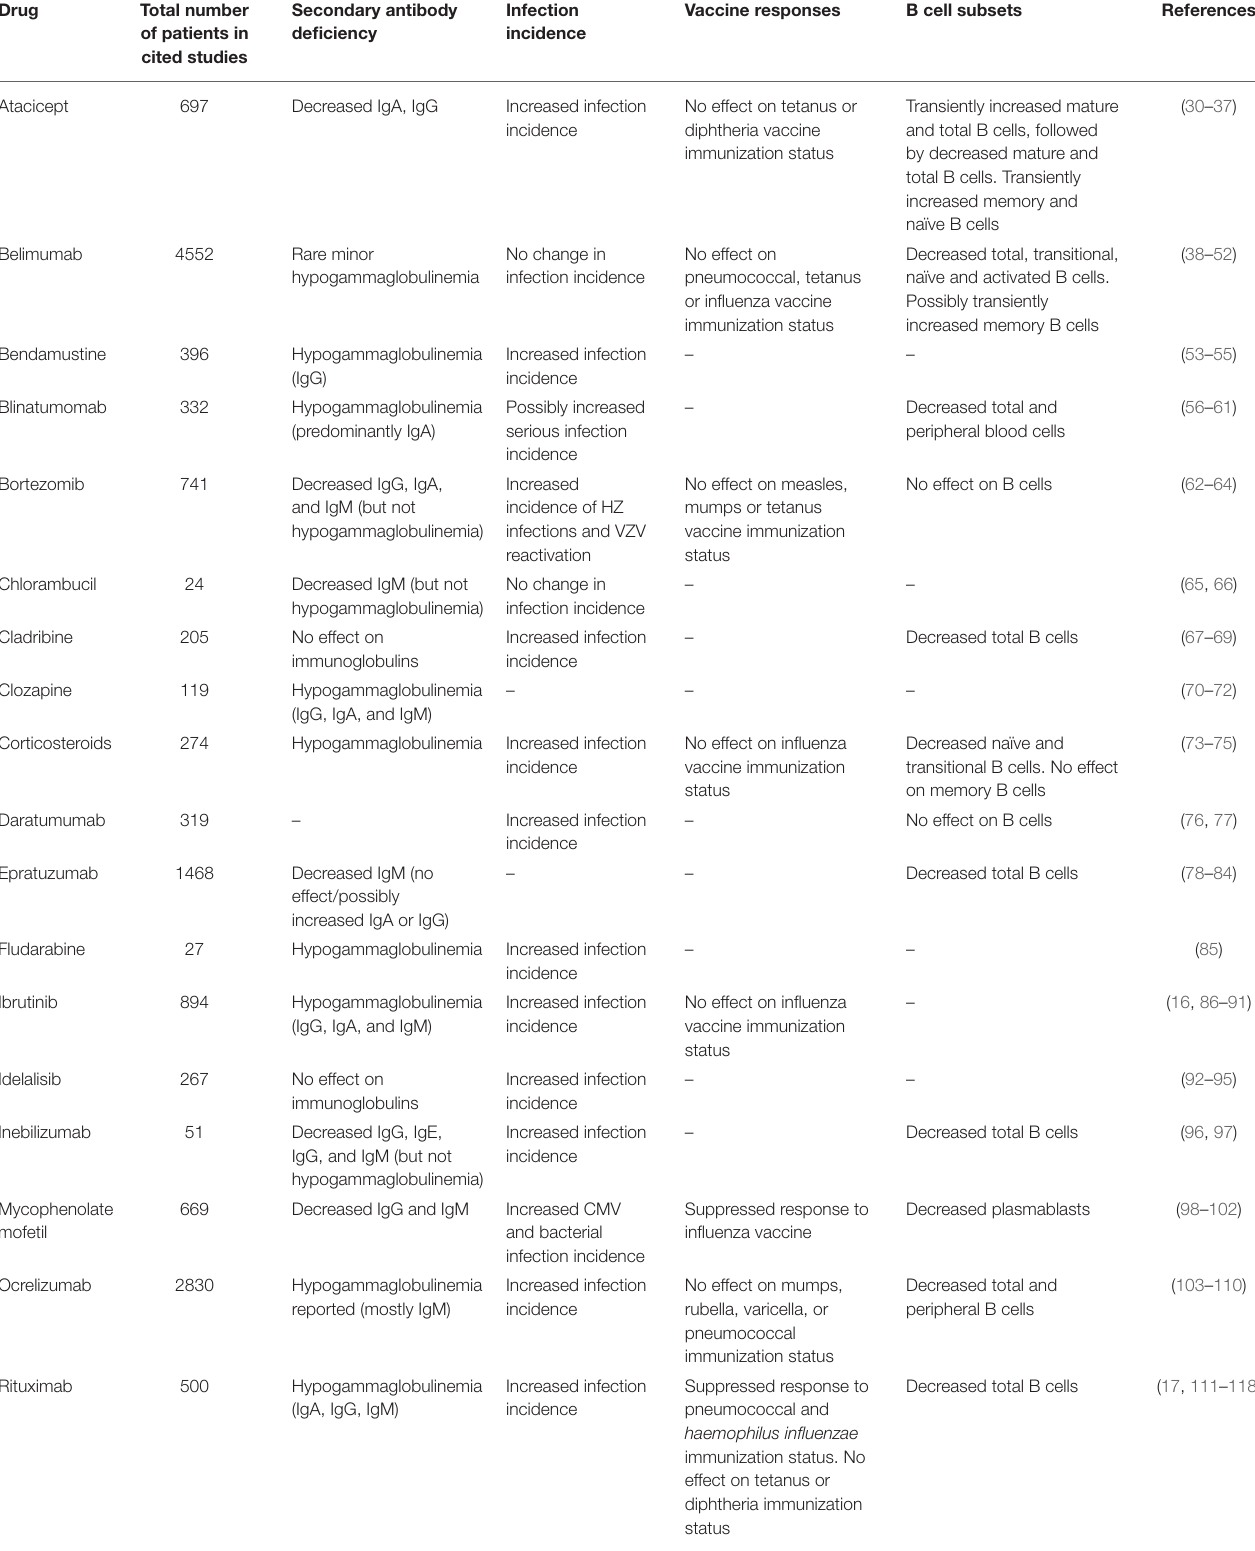
TABLE 1 | Reported outcomes of therapeutic agents with the potential to cause iatrogenic secondary antibody deficiency.